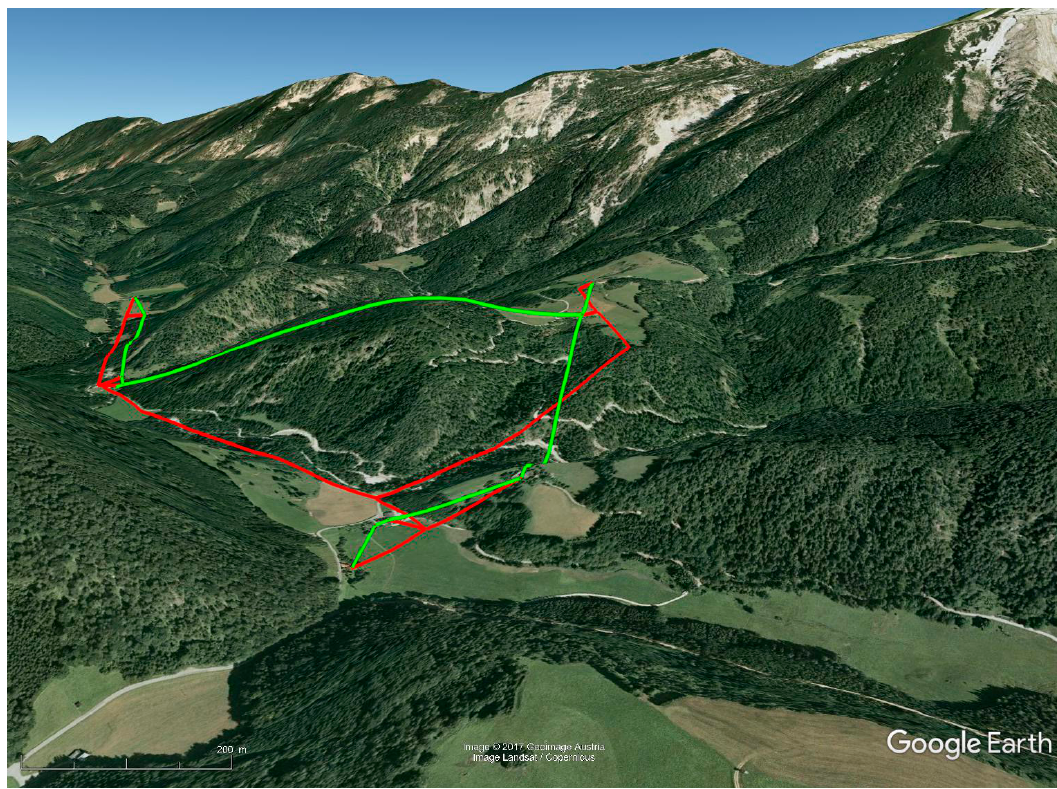
Figure 15. Example demonstrating difficulties of benchmarking.